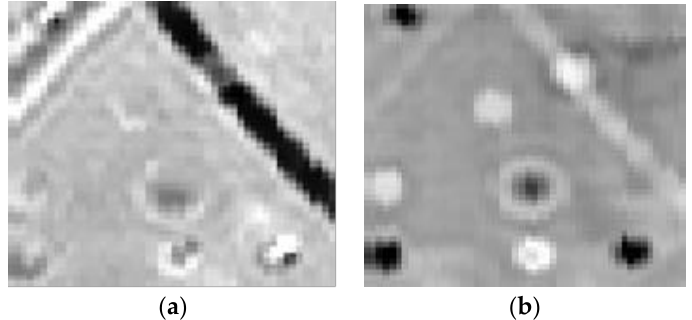
Figure 9. Cross- ( a ) and parallel ( b ) polarization-received signals recorded at a frequency of 4.0 GHz [39]. These images were recorded for a test wall inside of which small coins and metal wires were placed at different depths.